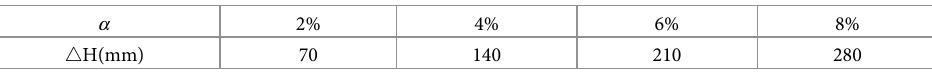
Table 1. Influence of lateral slope on the elevation difference between ending points.